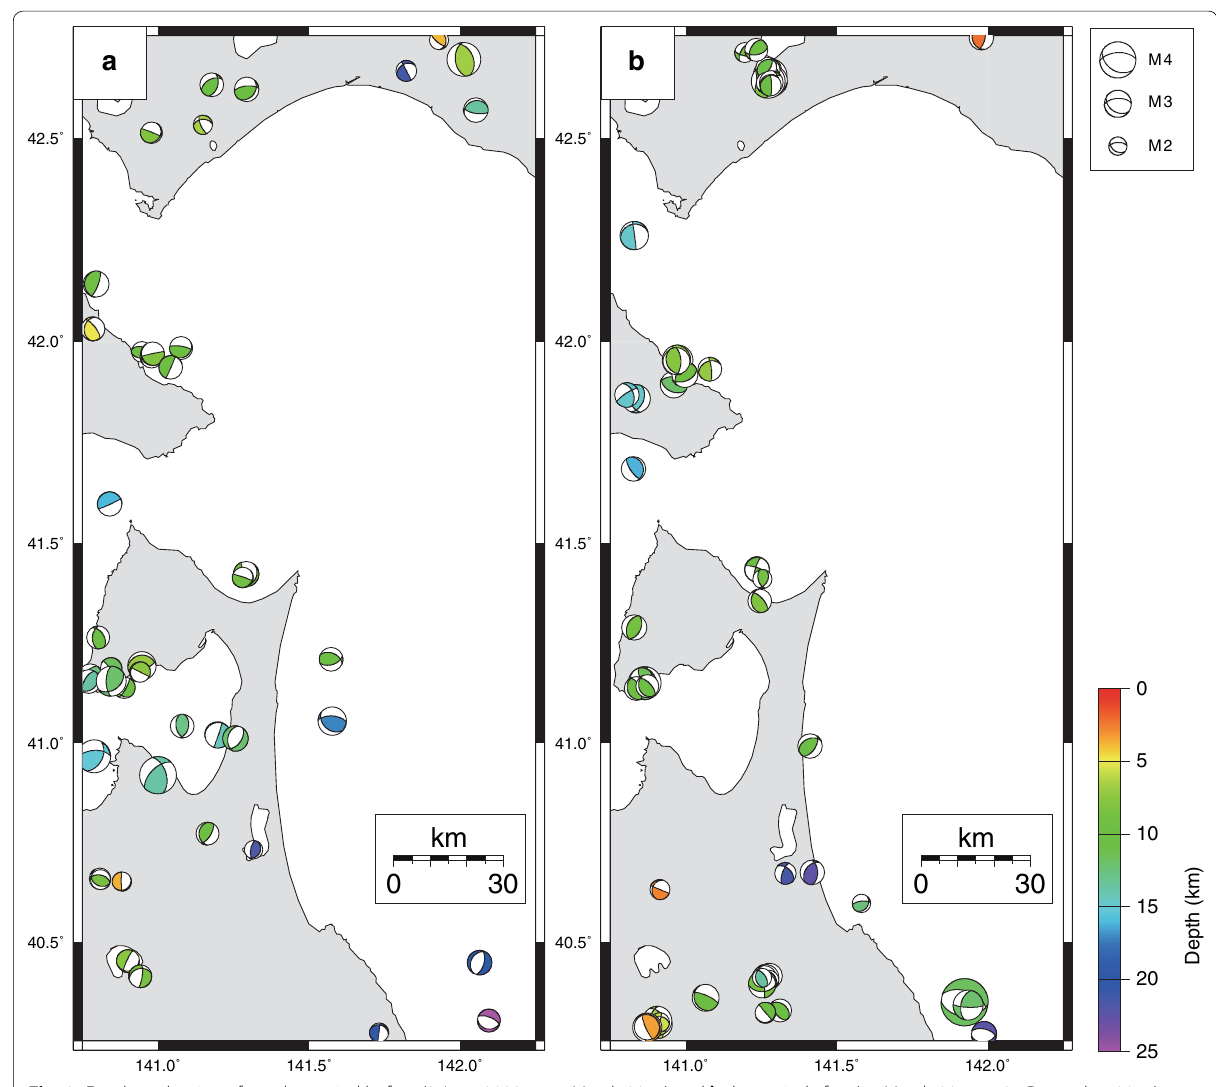
Fig. 2 Focal mechanisms for a the period before (3 June 2002 to 11 March 2011) and b the period after (11 March 2011 to 31 December 2017) the Tohoku earthquake. Focal mechanisms (equal-area lower-hemisphere projections) are shown by beach ball symbols with size proportional to magnitude. The color scale shows hypocenter